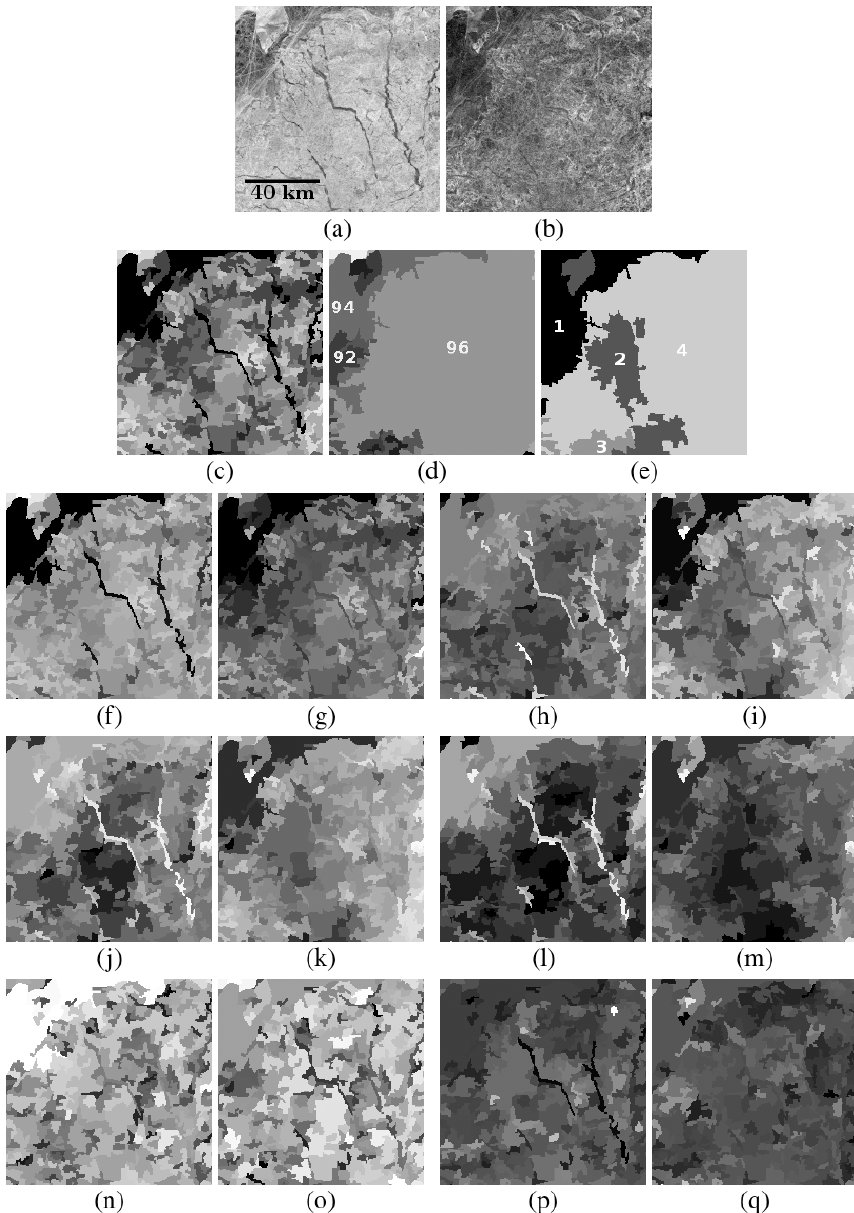
Figure 5. Example of SAR features computed for the central part of the Bay of Bothnia. (a–b) Original SAR HH and HV in 500m resolution. (c) Segmentation result of the first principal component of the original HH and HV SAR channels. (d) SIC (1–100%), (e) FIS DIR (1–4), (f–g) segment means, (h) AC HH , (i) AC HV , (j) E HH , (k) E HV , (l) CV HH , (m) CV HV , (n) ED HH , (o) ED HV , (p) K HH , (q) K HV